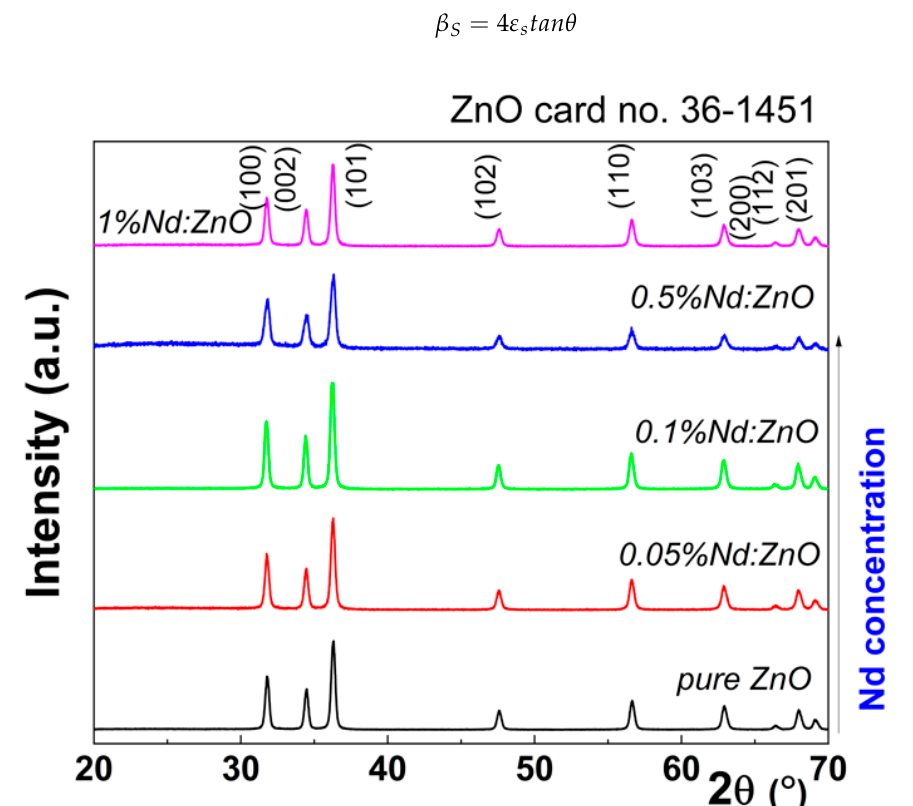
Figure 1. X-ray diffraction patterns for pure ZnO and Nd-doped nanostructures. Figure 1. X-ray di ff raction pa tt erns for pure ZnO and Nd-doped nanostructures. From Equation (1), one can observe that the size broadening depends on 1/ cos θ , while In each case, XRD pa tt erns present di ff raction peaks located at 20 = 31.79, 34.45, 36.26, the strain broadening depends on tan θ . Briefly, the Williamson–Hall method assumes that 47.67, 56.62, 62.89, 66.45, 68.18, and 69.12, further indexed as (100), (002), (101), (102), (110), size and strain contributions are additive factors of the total breadth of the diffraction peak [17,18], thus the convolution is either a simple sum or a sum of squares. Combining (103), (200), (112), and (201) re fl ections of ZnO (ICDD card no. 00-036-1451) with a = b = Equation (1), it can be obtained: 0.324 nm and c = 0.517 nm (spatial group P 63 mc(186) with hexagonal symmetry). Other